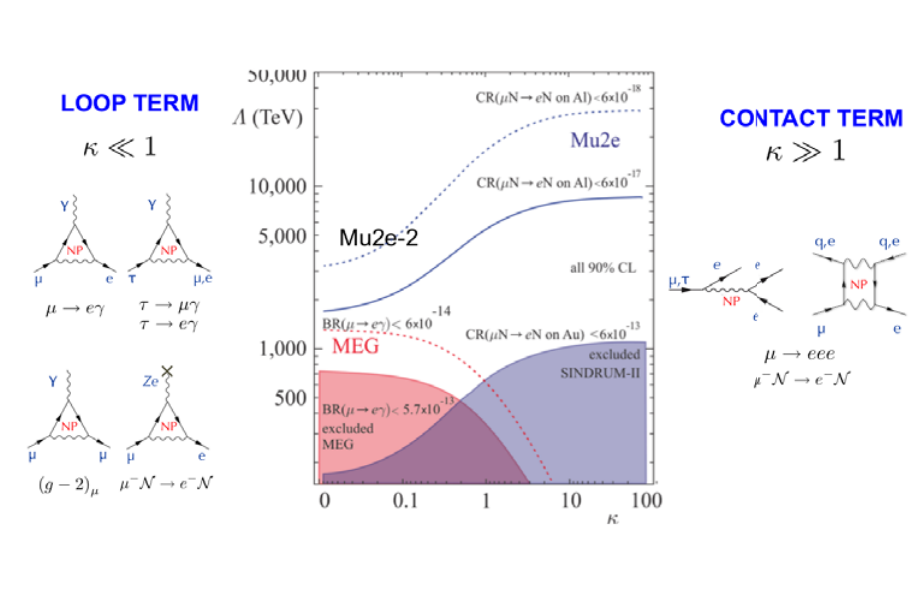
Figure 1. Sensitivity of μ → e γ , μ → e transition and μ → 3 e to the scale of new physics Λ as a function of the parameter κ . The shaded areas are excluded by present limits. On the left (right) side, the dipole (four-fermion) diagrams are shown for the di ff erent CLFV processes.